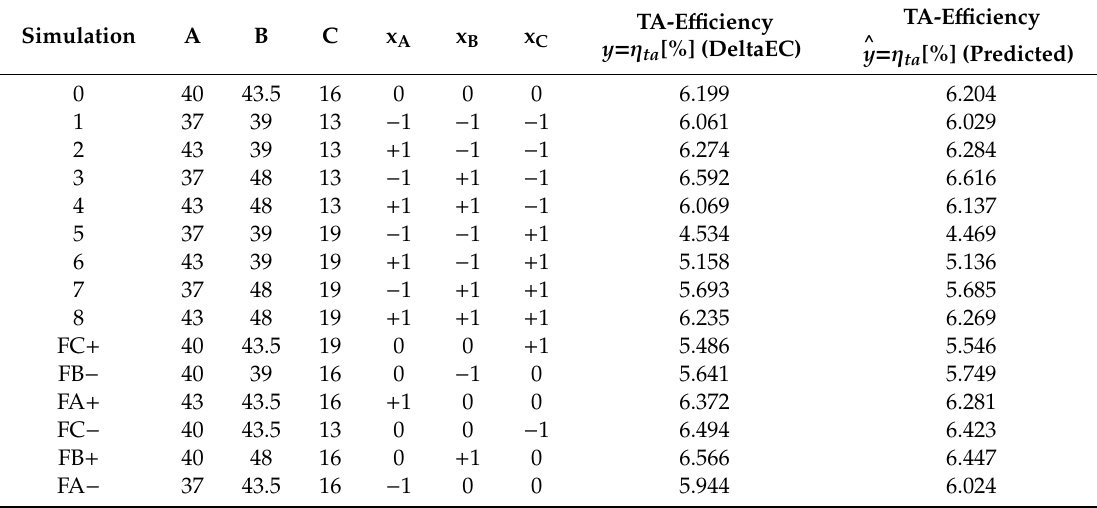
Table 5. Experimental design matrix and FCD–RSM results for thermoacoustic e ffi ciency at “Junction” for